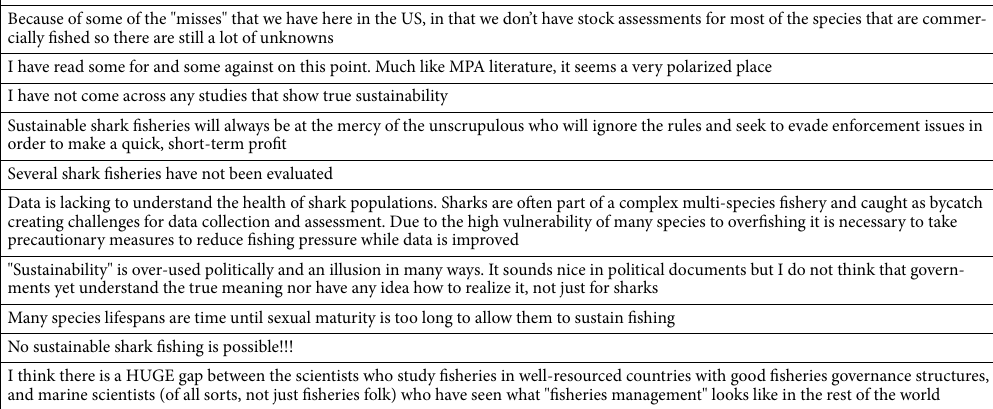
Table 1. Representative example responses showing reasons why respondents do not agree with the statement that sustainable shark fishing is possible, including references to literature on this topic.